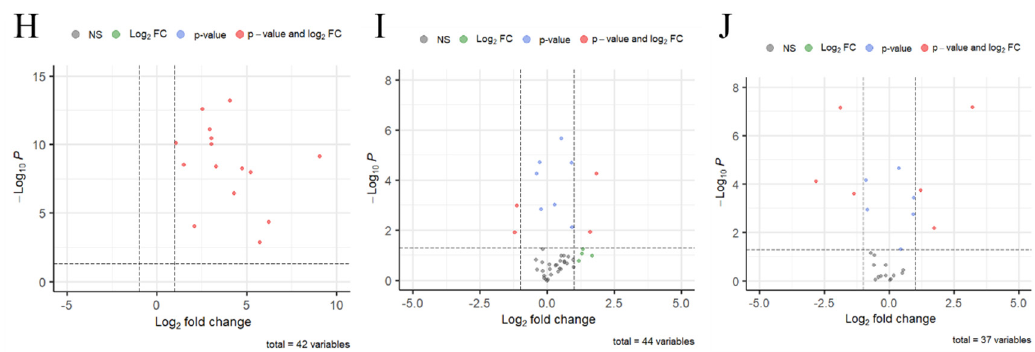
Figure 3. The RNA sequence of the spore − like propagule and the hypha. ( A ) The amount of all up − regulated and down − regulated genes between the spore-like propagule and the hypha. ( B ) The heat map of the 20 highest up − regulated genes and the 20 lowest down − regulated genes between the spore − like propagule and the hypha. |log2(N/G)| > 1, p < 0.05. ( C ) The enhanced volcano of 13,590 genes expression between the eight spore-like propagules and the hyphae. |log2(N/G)| > 1, p < 0.05. ( D ) Pie chart of the most significantly enriched categories within the up − regulated genes between the spore − like propagule and the hypha. The method was GO and the referenced species was Aspergillus niger CBS513.88 (AspGD). ( E ) Pie chart of the most significantly enriched categories within the down − regulated genes between the spore − like propagule and the hypha. The method was GO and the referenced species was Aspergillus niger CBS513.88 (AspGD). ( F ) The enriched patways of differentially expressed genes between the spore − like propagule and the hypha. |log2(N/G)| > 1, p < 0.05. ( G ) The enhanced volcano of 416 MAPK signaling pathway genes expression between the spore − like propagule and the hypha. |log2(N/G)| > 1, p < 0.05. ( H ) The enhanced volcano of 42 conidia-associated genes (CAGs) expression between the spore-like propagule and the hypha. |log2(N/G)| > 1, p < 0.05. ( I ) The enhanced volcano of 44 germination-associated genes